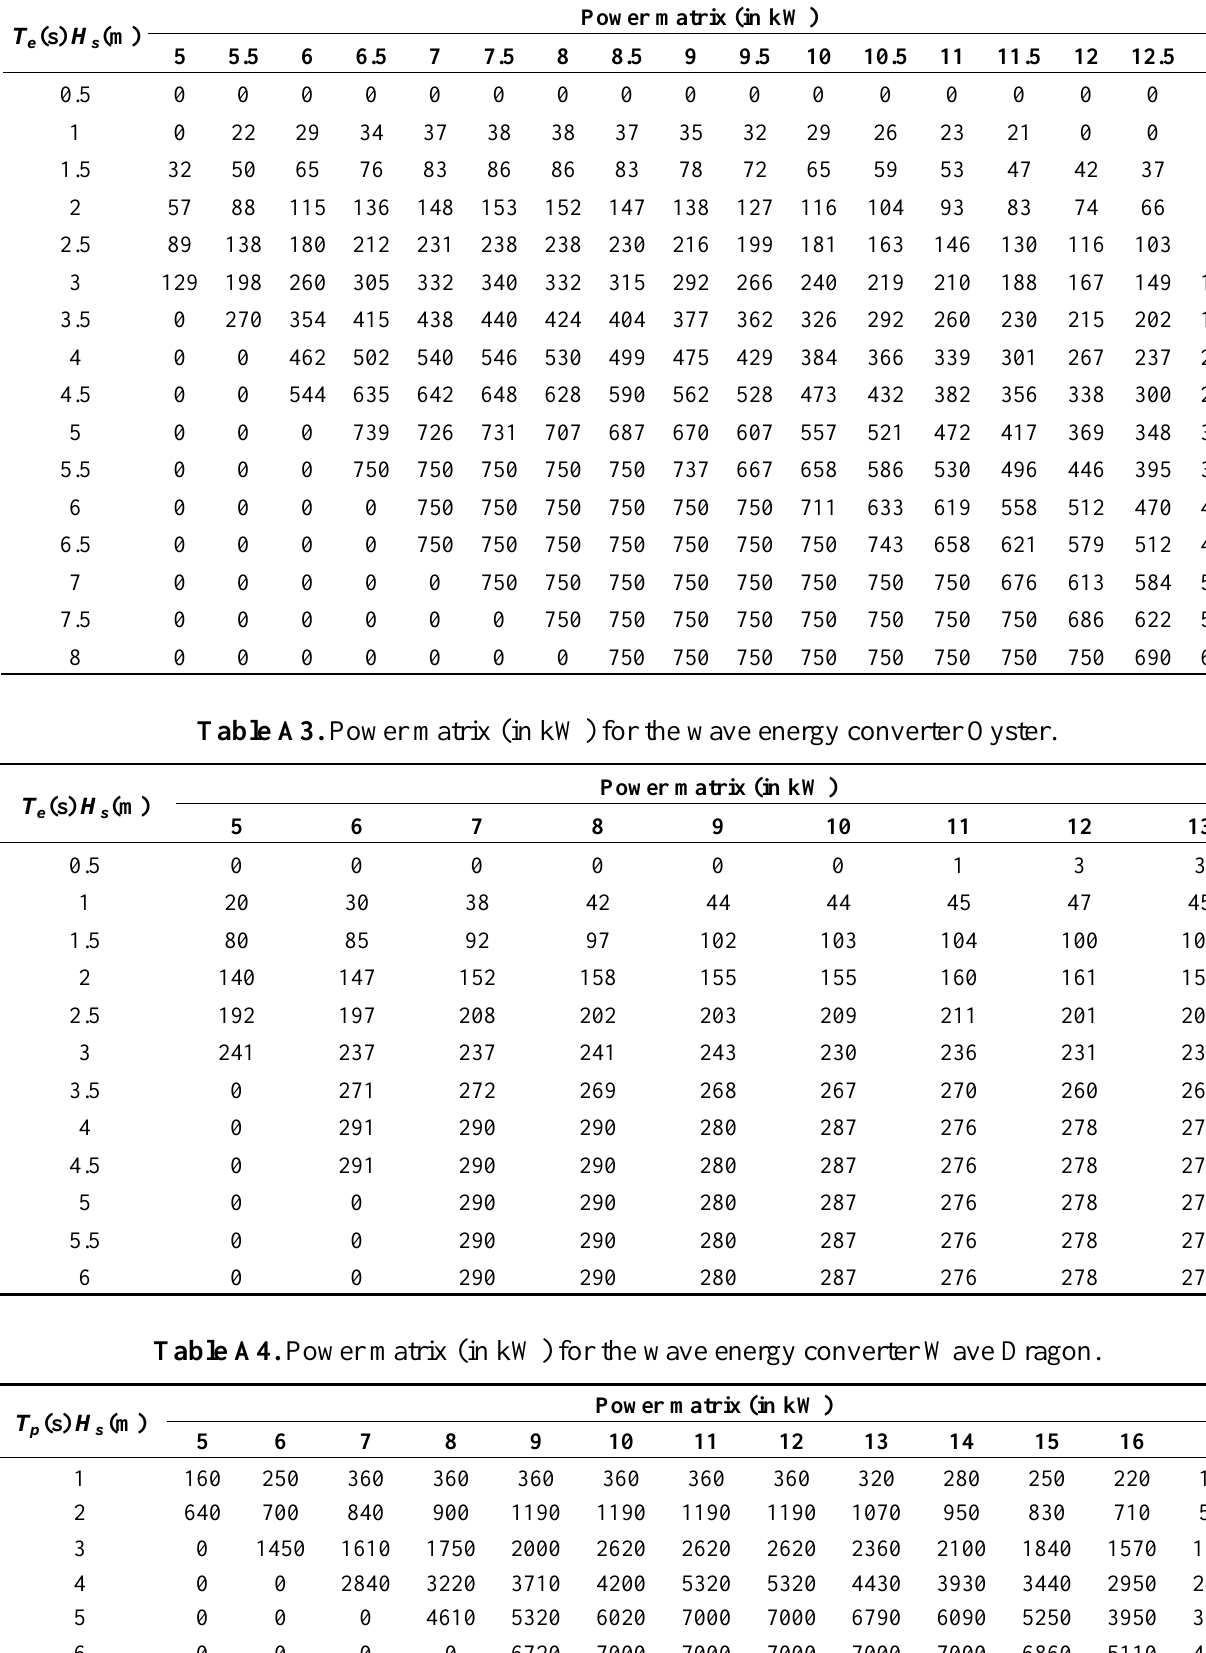
Table A2. Power matrix (in kW) for the wave energy converter Pelamis.